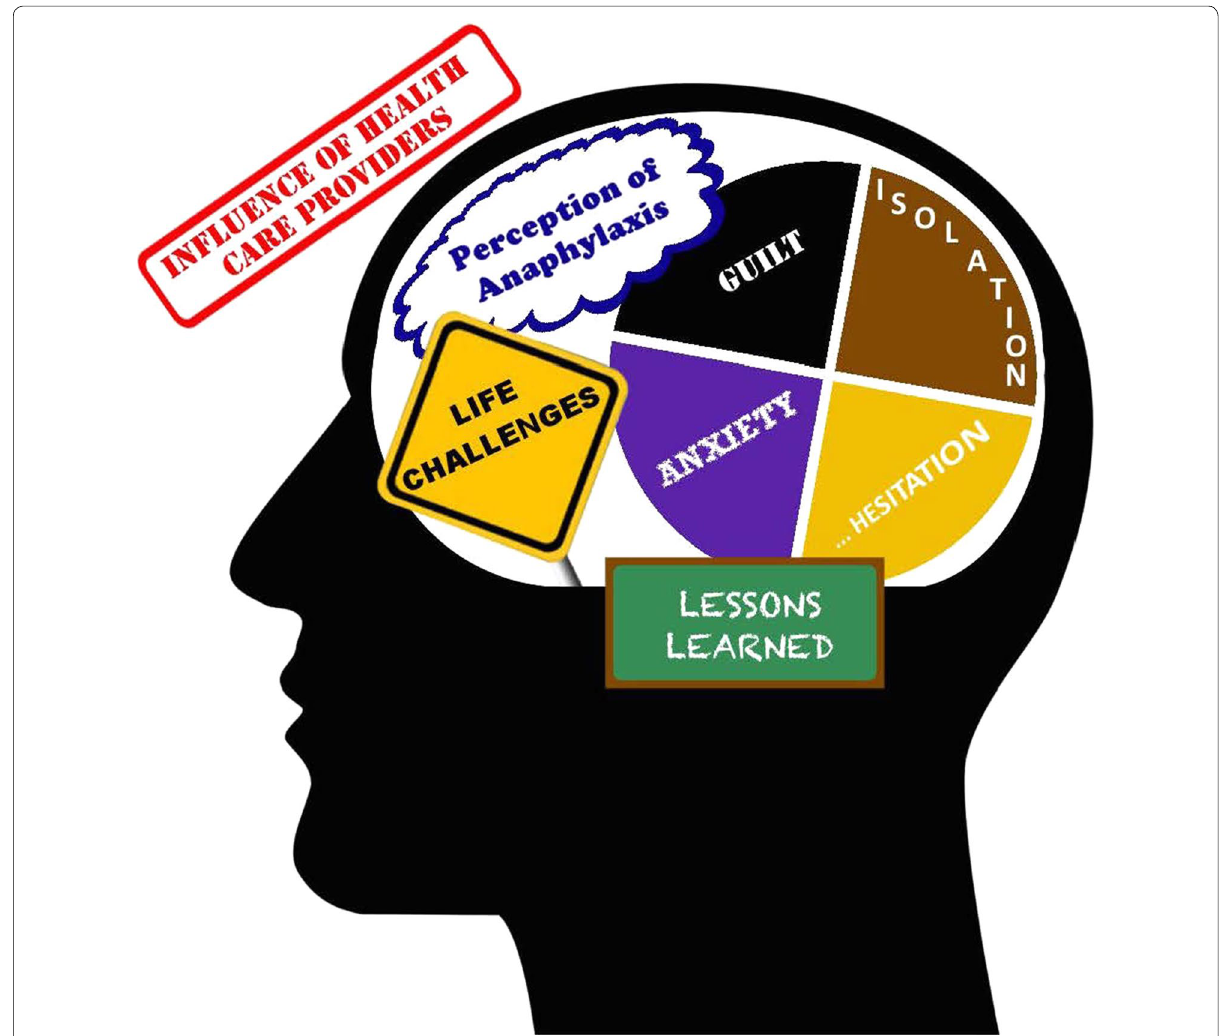
Constant anxiety and a visceral fear Anxiety and fear are parental instincts that intensify when their child has been diagnosed with a food allergy. Participants described a constant feeling of